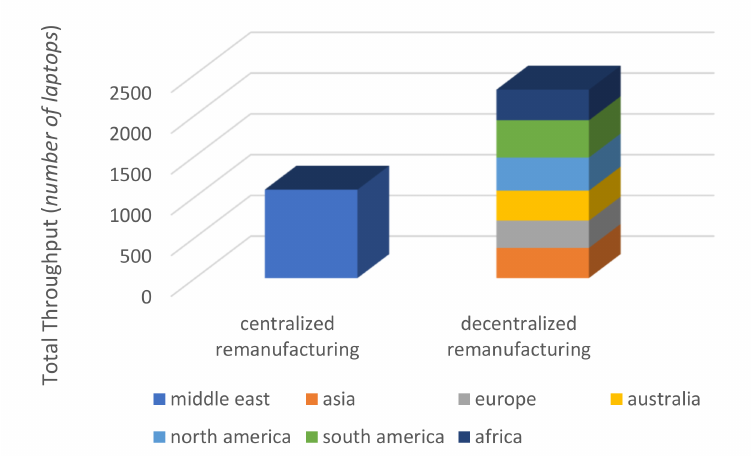
Figure 9. Total throughput of centralized and decentralized